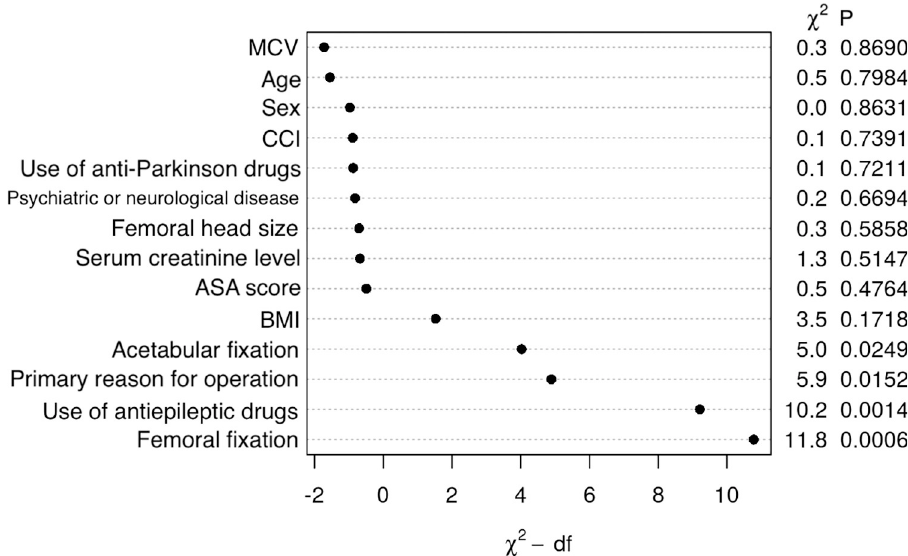
Fig 2. The Chi-squared regression coefficients with p values for the predictors in the Model I (logistic regression model). Femoral fixation was the most important and MCV the least important predictor in this model. MCV = Mean corpuscular volume, CCI = Carlson Comorbidity Index, ASA score = American Society of Anesthesiologists score, BMI = Body mass index.